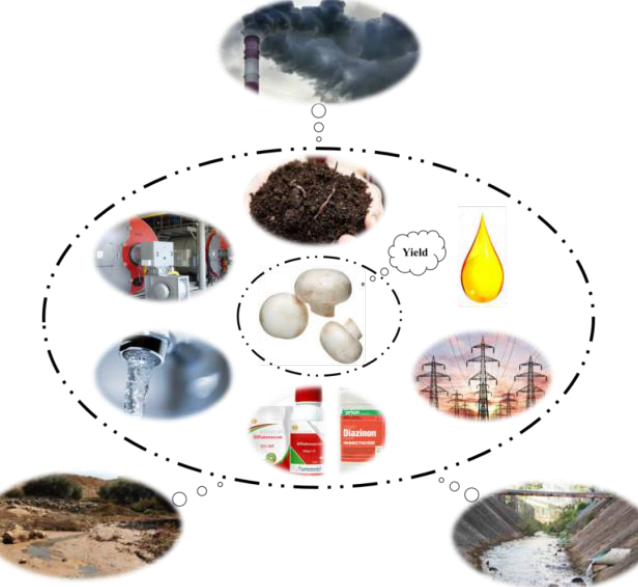
Figure 2. System boundaries of mushroom production in Isfahan province.